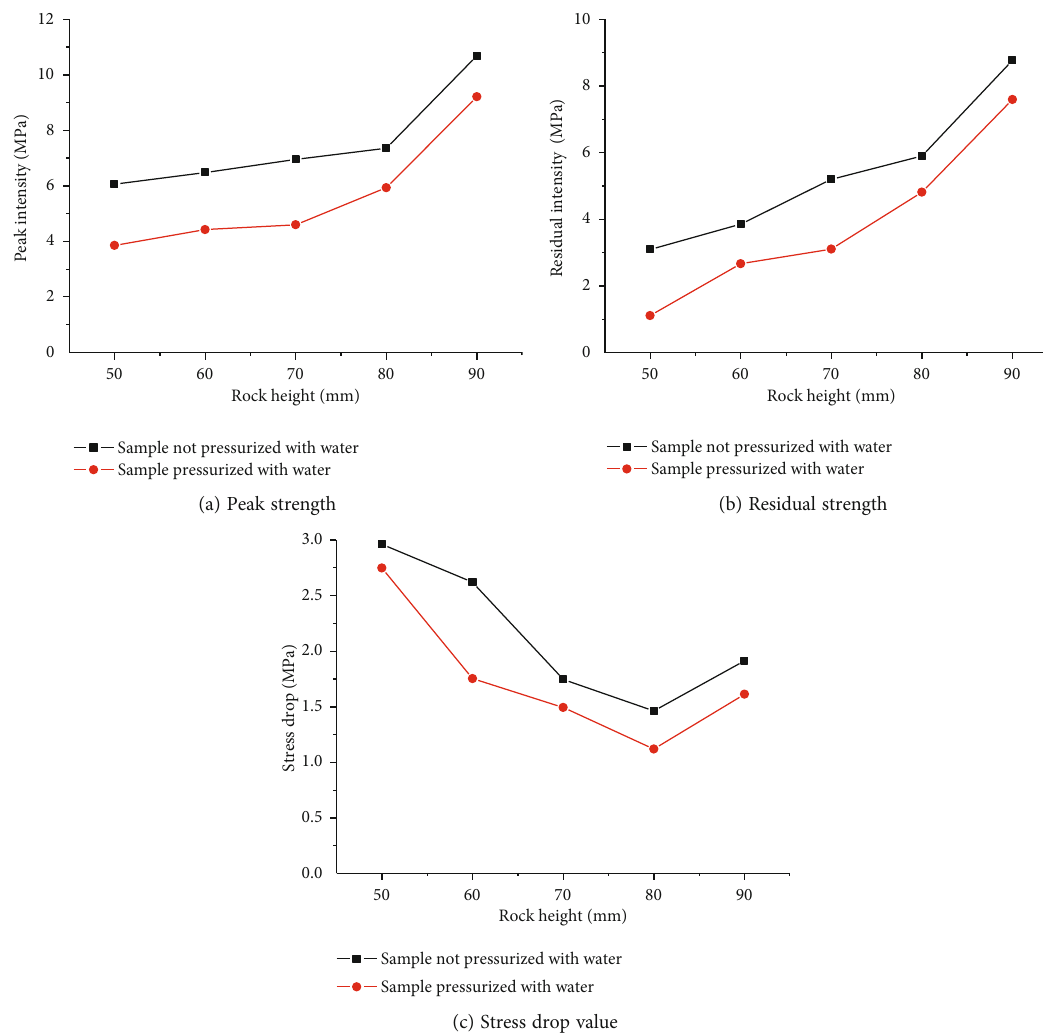
Figure 8: Strength